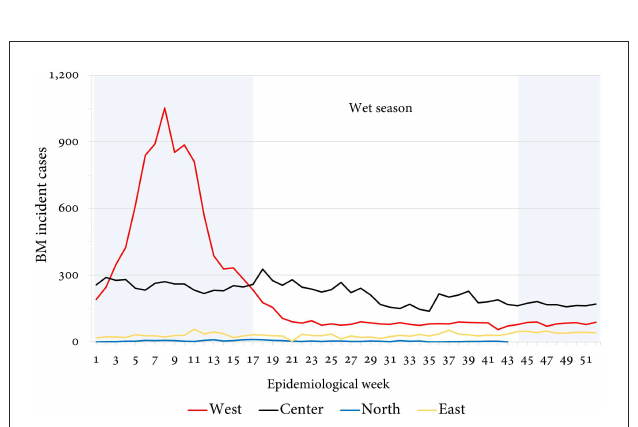
FIGURE3 Report of incident cases by epidemiological week per AMB sub-region. FIGURE4